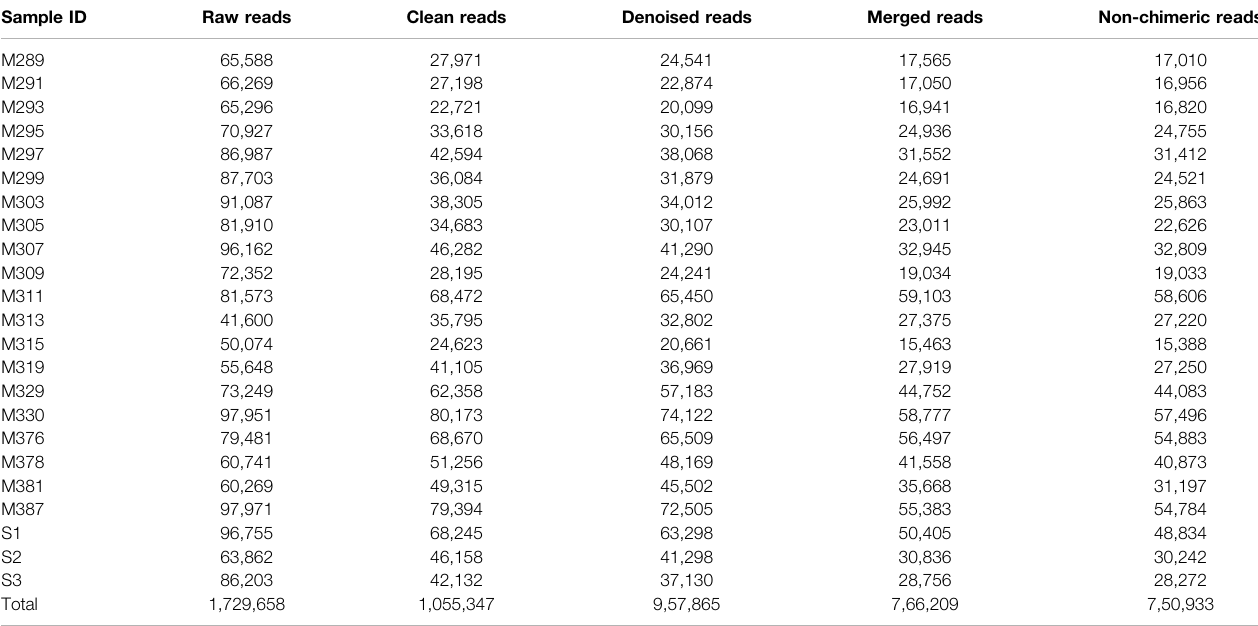
TABLE 1 | Statistics of sample sequencing data processing results. Sample ID